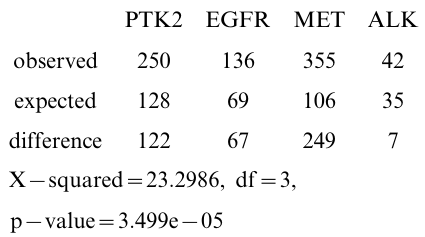
FIgure S2 Spearman and Euclidean distance matrices were combined for the Spearman-Euclidean Distance (SED) graph plotted in three dimensions with PyMOL. Multidimensional scaling was used to determine node coordinates in three dimensions; A shows the x–y dimension, B , x–z. Groups of proteins (identified by different colors) were selected manually. ( C, D ) Three-dimensional t-SNE embedding of SED dissimilarity plotted as in A and B. 49 groups of proteins (identified by different colors, filtered by low percent NA in the primary data) were selected using a minimum spanning tree method [63] that finds groups that can be connected by a single linkage. Figure S3 Two-dimensional t-SNE embedding of Spearman- Euclidean dissimilarity graphed in Cytoscape with RCytoscape. Total phosphorylation is represented by node size and color as in Figure S1. Node position was adjusted slightly for clarity. (PDF) Figure S4 Heat maps of clusters that contained the most highly tyrosine phosphorylated proteins in lung cancer samples, which ranked at the top based on the index for evaluation (see Materials and Methods). Clusters from ( A ) k -means on Euclid dissimilarity; ( B ) t-SNE on on Euclid dissimilarity; ( C ) t-SNE on Spearman dissimilarity; ( D ) t-SNE on Spearman-Euclid dissimilarity; ( E ) filtered combined cluster from ( B ) and ( C top). In ( C ), the third- ranked cluster containing LCK is also shown (bottom); LCK was included in all the other top-ranked clusters. Data are graphed as a heat map in which black represents NA and increasing scaled peptide counts are shown on a blue-yellow scale (color keys are shown at the left). Data are ordered by decreasing sums of scaled peptide counts for genes (decreasing from top to bottom) and samples (decreasing from left to right). Figure S5 Heat maps of clusters that ranked second for contents of tyrosine phosphorylated proteins in lung cancer samples, graphed as in Figure S4, derived from ( A ) k -means on Euclid dissimilarity; ( B ) t-SNE on on Euclid dissimilarity; ( C ) t-SNE on Spearman dissimilarity; ( D ) t-SNE on Spearman-Euclid dissimi- larity; ( E ) filtered combined cluster from ( B ) and ( C ). EGFR was in all of these clusters except that derived from k -means on Euclid dissimilarity ( A ), where it was included in the top-ranked cluster (Figure S4A). Figure S6 Heat maps of clusters that contained MET, graphed as in Figure S4, derived from ( A ) k -means on Euclid dissimilarity; ( B ) t-SNE on Euclid dissimilarity (low-abundance data filtered); ( C ) t-SNE on Spearman dissimilarity; and ( D ) t-SNE on Spearman- Euclid dissimilarity. Figure S7 Heat maps of clusters that contained ALK, graphed as in Figure S4 (color keys omitted), derived from ( A ) k -means on Euclid dissimilarity; ( B ) t-SNE on Euclid dissimilarity; ( C ) t-SNE on Spearman dissimilarity; and ( D ) t-SNE on Spearman-Euclid dissimilarity (low-abundance data filtered). Figure S8 Heat maps of combined filtered clusters that contained ALK and EML4, graphed as in Figure S7. A